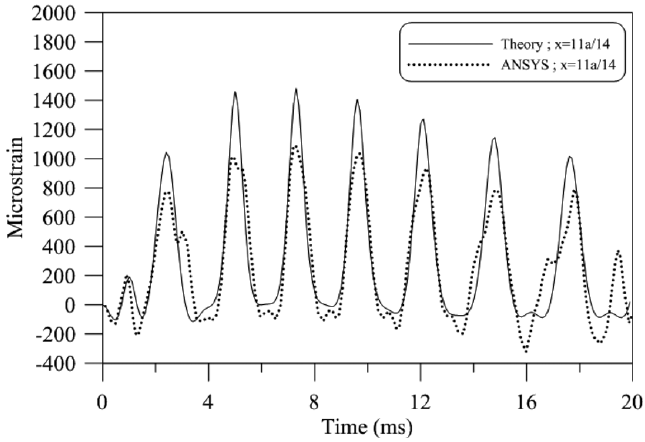
Fig. 12. The strain-time history ( ε xb − t ) at bottom surface of point (7a/14, b/2).